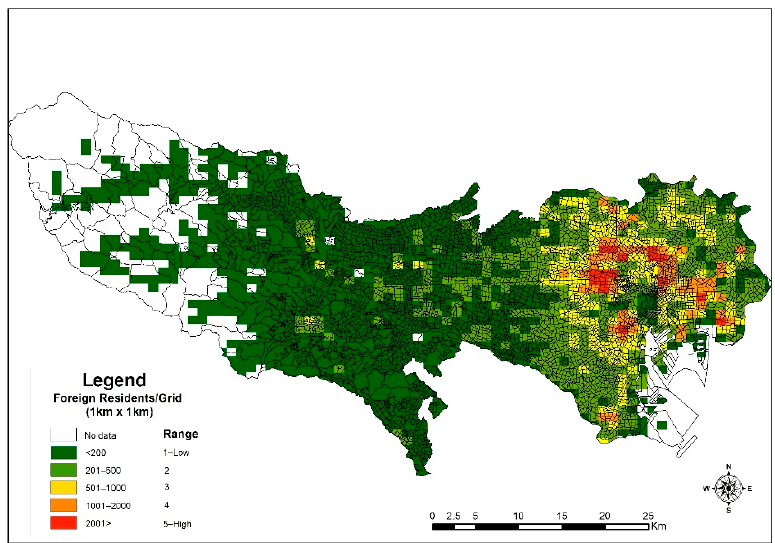
Figure 4. Population density of non-Japanese.